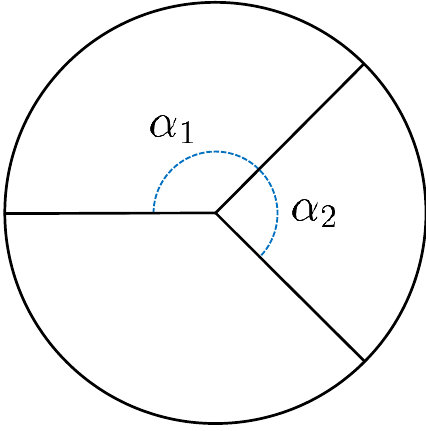
Figure 2 . In the semiclassical regime, the additivity rule (1.7) for discrete momenta of large spin double-twist operators translates into additivity of conical defect angles in AdS 3 , where the de(cid:12)cit angle is (cid:1) (cid:30) = 4 (cid:25) (cid:11) . The leading-twist operator, whose dual conical defect is depicted as the Q